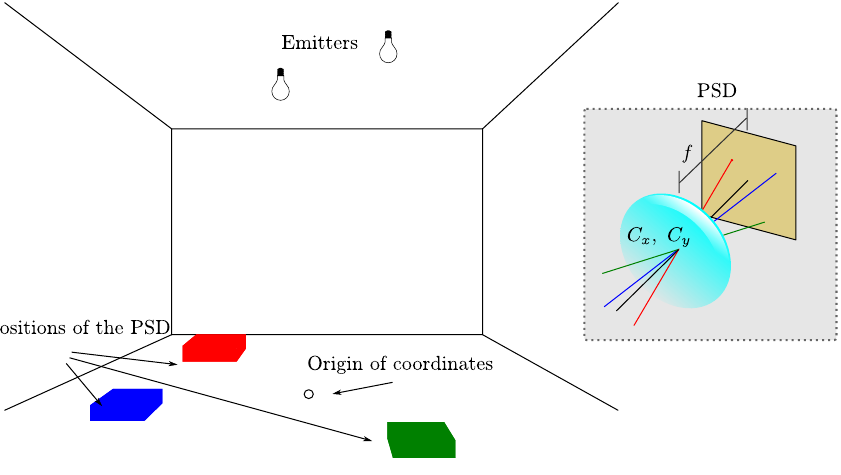
Figure 2. Calibration